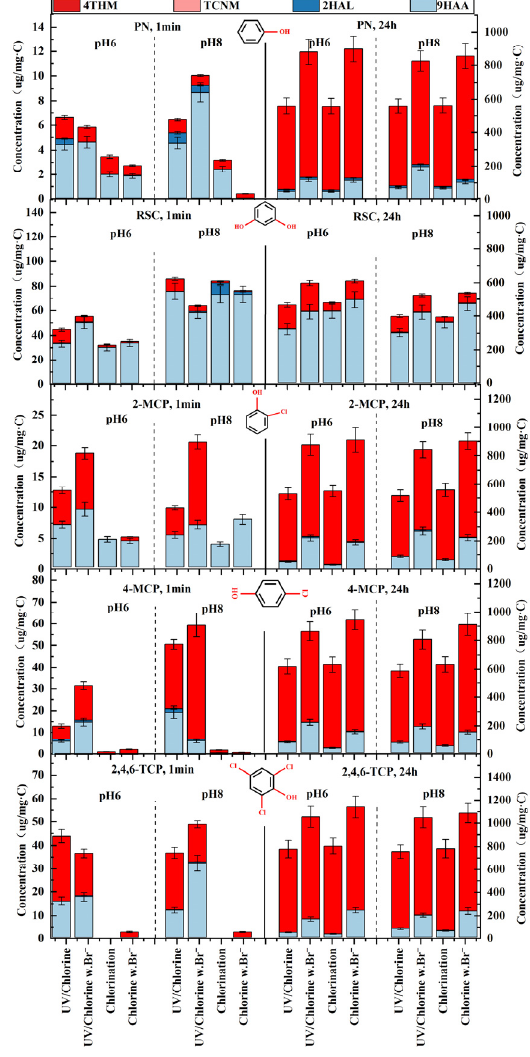
Figure 4. The formation of 4THM, 9HAA, 2HAL, and TCNM during the 1 min short-term oxidation and 24 h post-chlorination from five active benzene derivatives. Short-term oxidation conditions: Chlorine dose = 10 mg chlorine/L, pH = 6.0 or 8.0, [model benzene precursors] 0 = 3 mg-C/L, UV fluence rate = 10 mW/cm 2 , [bromide] 0 = 1 mg/L. Post-chlorination conditions: pH = 8.0, chlorination time = 24 h, chlorine residual = 1.0 ± 0.4 mg/L, dark, 22 °C.